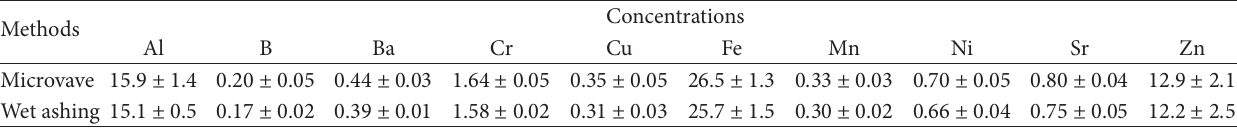
Table 3: Trace metal contents ( 𝜇 gg − 1 ) with microvave and wet ashing methods in Silurus glanis sample (mean ± S.D., 𝑁 = 4 ).